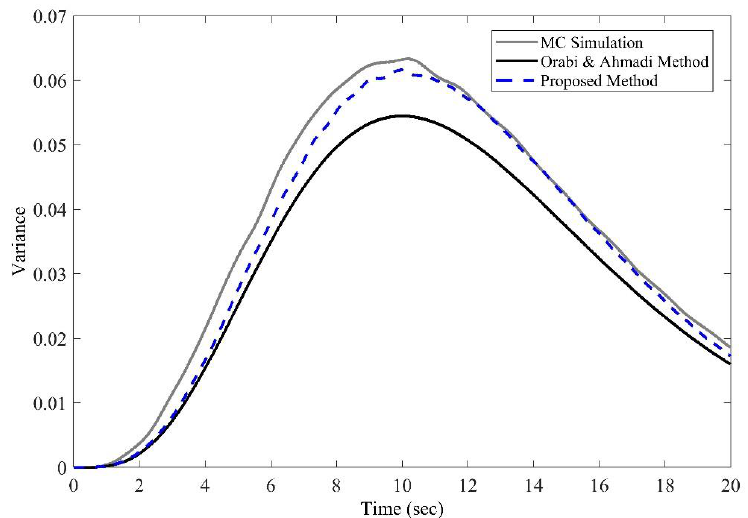
Figure 6. Mean square displacement response due to nonstationary excitation. ( γ = 1.0, μ = 1.0).